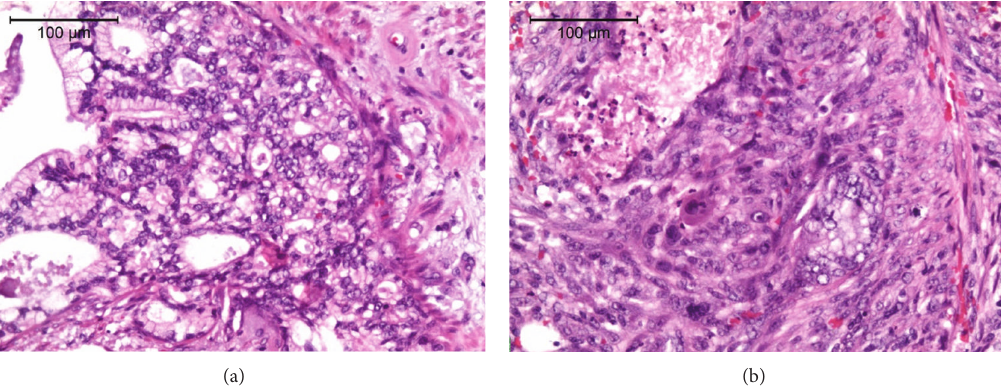
Figure 1: (a) Histologic section of prostatic carcinosarcoma with characteristic findings. (b) Histologic section of prostatic carcinosarcoma with characteristic findings.